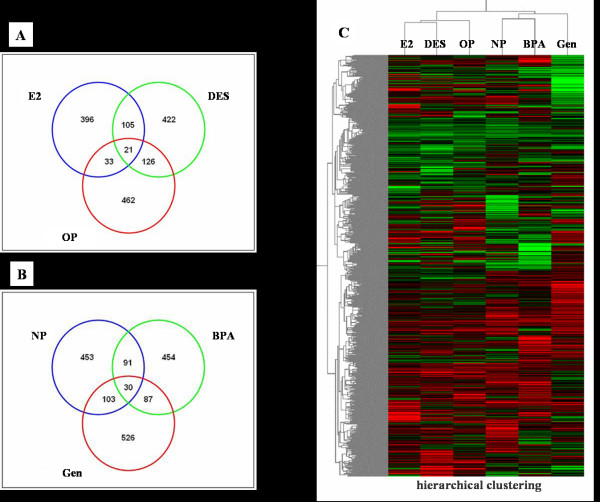
Venn diagram showing the number of genes induced by E2 and EDs. The altered gene profiles by E2, OP and DES (overlapped 21 genes; A) or NP, BPA and Gen (overlapped 30 genes B), respectively, were summarized. A hierarchical clustering analysis (C) was performed following treatments with E2 and other EDs in the uterus of immature rats. Two-dimensional hierarchical clustering was applied to the expression data from 7.5 k genes, which showed significant changes in the balanced differential expression. Increased expression levels are shown in red and decreased expression levels are shown in green.